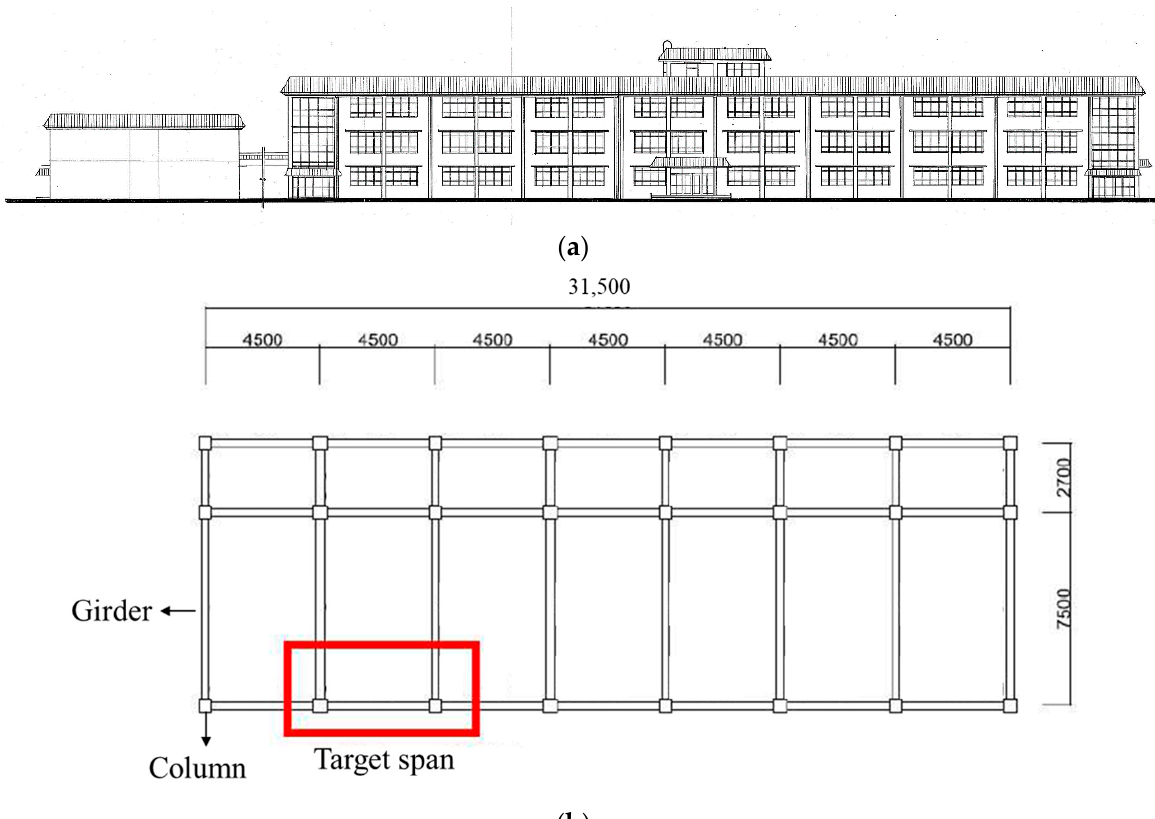
Figure 3. Benchmark structures. ( a ) Exterior elevation; ( b ) floor plan (mm).